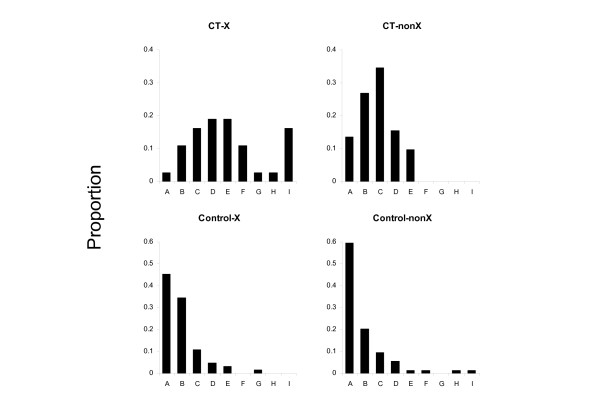
Distribution of dN/dS ratios for CT genes and controls. The proportion of genes in each category with ratios in intervals A-I is shown. The categories are: CT-X, CT genes on chromosome X (N = 33); CT-nonX, CT genes not on chromosome X (N = 49); Control-X, control genes on chromosome X (N = 64); Control-nonX, control genes not on chromosome X (N = 71). The intervals are: 0 ≤ A ≤ 0.25; 0.25 < B ≤ 0.5; 0.5 < C ≤ 0.75; 0.75 < D ≤ 1.0; 1.0 < E ≤ 1.25; 1.25 < F ≤ 1.5; 1.5 < G ≤ 1.75; 1.75 < H ≤ 2; 2 < I ≤ 4. Genes which had no synonymous changes (dN/dS denoted '∞' in Table 2) were omitted from the analysis.